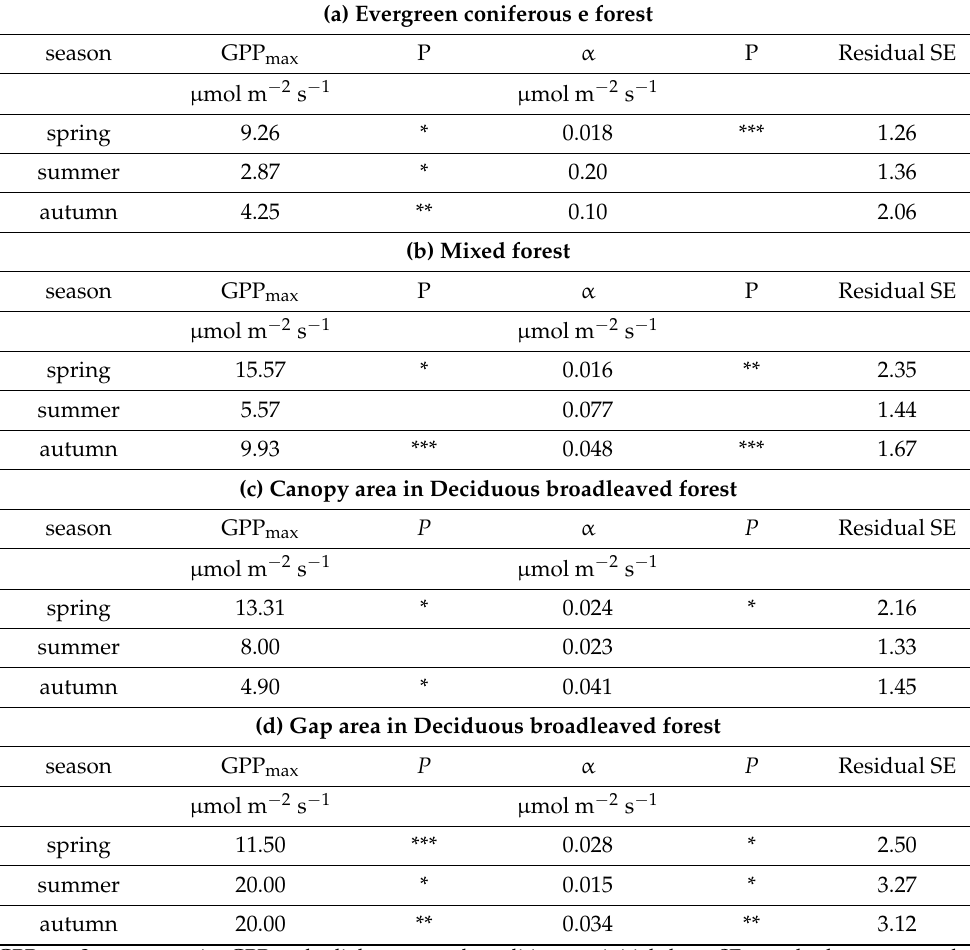
Table 1. Parameters of the light- Sasa community GPP curve in the four